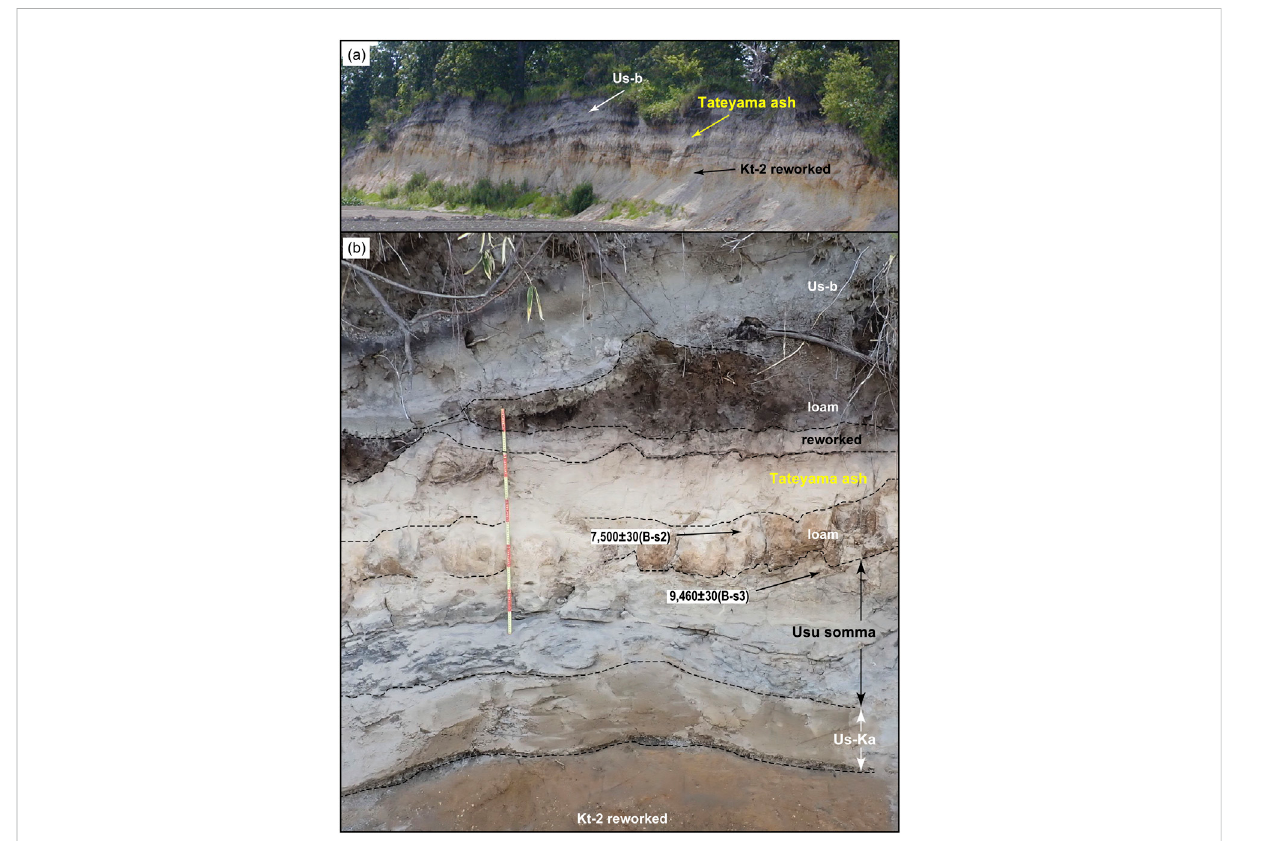
FIGURE 10 (A) PhotographoftheoutcropatlocalityBontheplateauoftheTp fl deposit.Theheightoftheoutcropis20 – 10 m.Tephralayersandsoilshow a mantle bedding structure. (B) Close-up photograph of the middle section of the outcrop located 50 m to the right of photograph (A) , The stratigraphic section is displayed in Figure 6B.